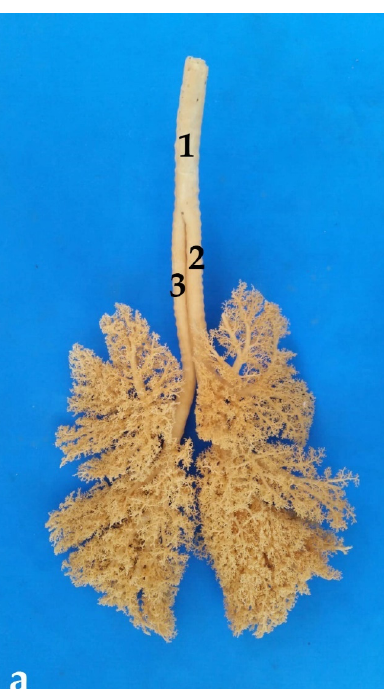
Figure 6. Ventral view of the neck and the thorax ( a ) and the neck and thoracic and abdominal cavities ( b ): (1) larynx; (2) trachea; (3) esophagus; (4) sternal manubrium; (5) thorax; (6) thyroid gland; (7) main bronchi; (8) right lung; (9) left lung; (10) heart; (11) diaphragm.